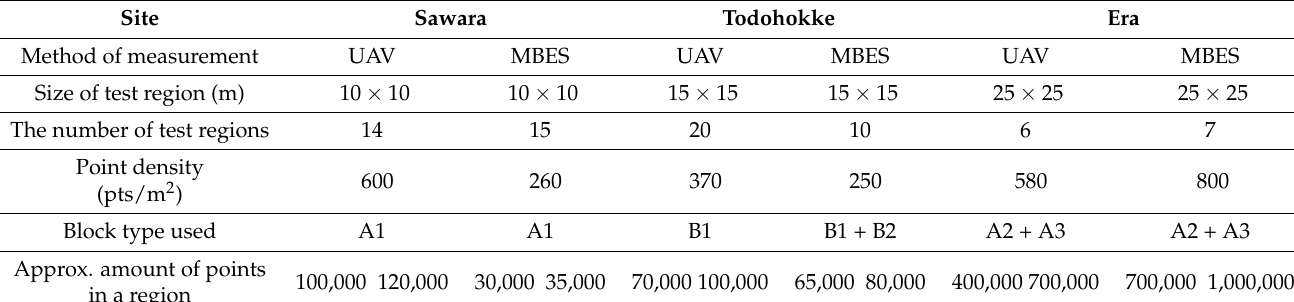
Table 1. Detail of point cloud data of three ports.